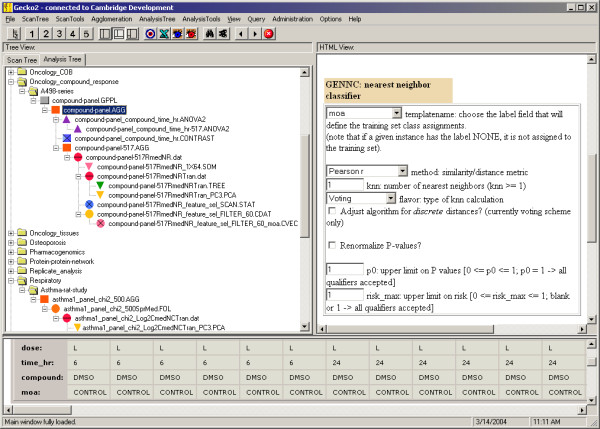
The Gecko user interface, showing Analysis Tree (upper left-hand-side), Browser (upper right-hand-side) and Properties windows (bottom). The Analysis Tree is opened on the A498 cell line data analyses described in the text (top), as well as on another independent study (bottom). An input form for a k-nearest-neighbor classifier is displayed in the Browser window. The experimental design for compound_panel.AGG (the selected object) is displayed in the Properties window.